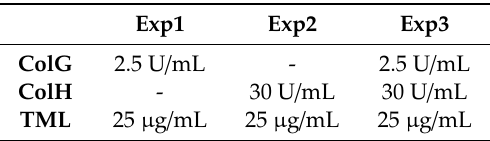
Table 1. Conditions herein used to digest